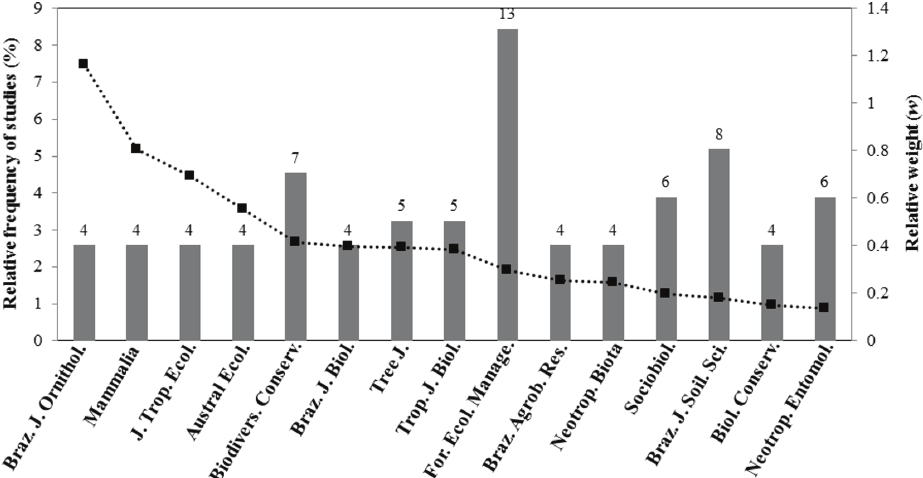
figure 1 - Journals with four or more publications with ecological studies in NNFP. The grey bars represent the number of studies and the black squares represent the relative weight (w) of each journal. The numbers on the bars represent the number of studies in each